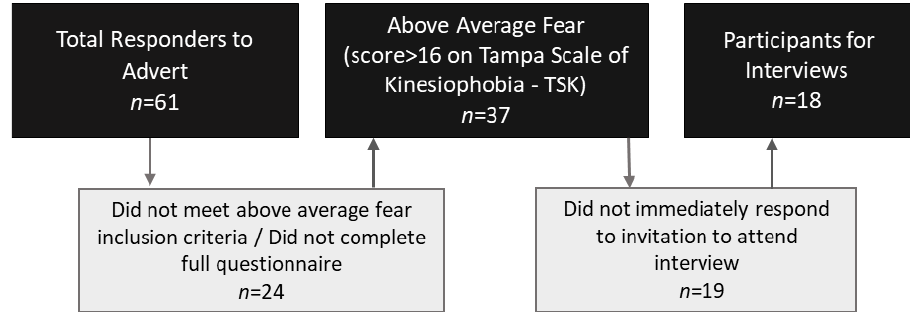
Figure 1. Flow diagram for participant recruitment.